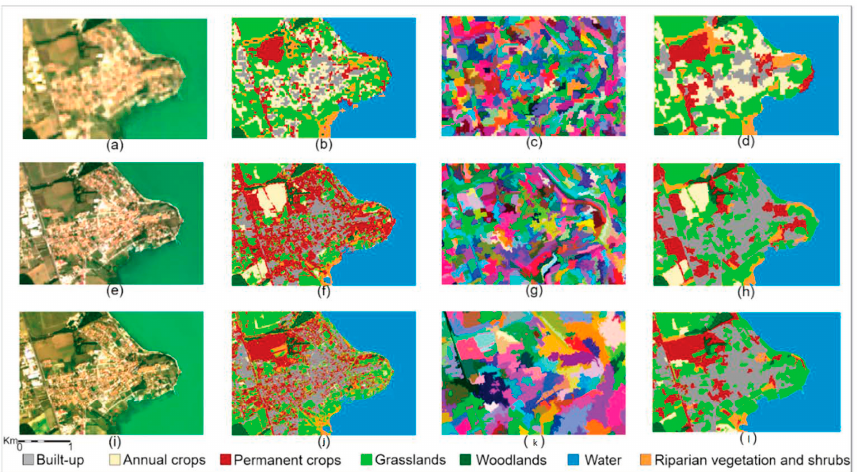
Figure 4. RGB image, pixel-based (PB) classification, spatial cluster (SC) identified by Simple Non-Iterative Clustering (SNIC), and object-oriented (OO) classifications of a portion of the study-area. ( a ) RGB image, ( b ) PB, ( c ) SC, ( d ) OO for Landsat 8; ( e ) RGB image, ( f ) PB, ( g ) SC, ( h ) OO for Sentinel